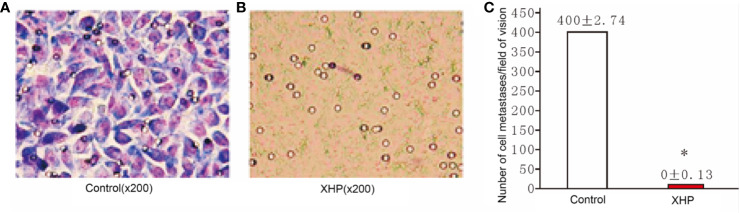
Effect of XHP on migration ability of MD-MB-231 cells (A, B) are the Giemsa staining maps of a random set of three duplicate wells in the control group and the XHP group, respectively; (C) is a histogram of the cell counts of the two groups. Each group of cells was randomly counted for nine fields of view; and take the average of the number of cells; compared with the control group, *P < 0.01.